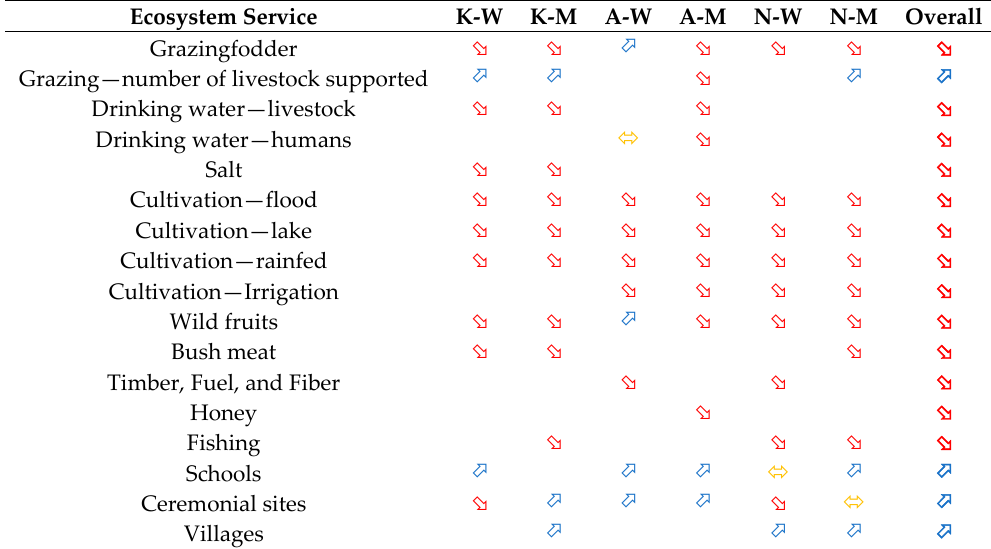
Table 2. Reported trajectories of change from the mapping activity, condensed to the most commonly mapped ecosystem services - indicates decrease, indicates increase, ⇔ indicates no change, and a blank space indicates the service wasn’t reported. The final column is the general reported direction of change in the region (K = Kopriay, A = Ayepa, N = Napasmuria, W = Women, M = Men).